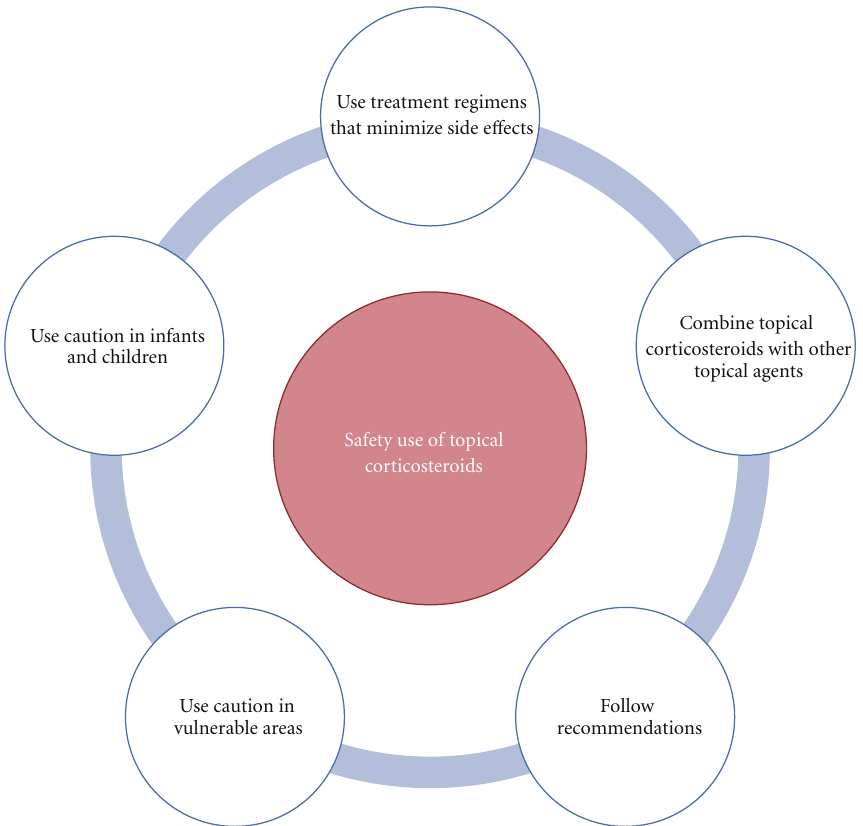
Figure 5: Strategies to improve safety for long-term use of topical corticosteroids in